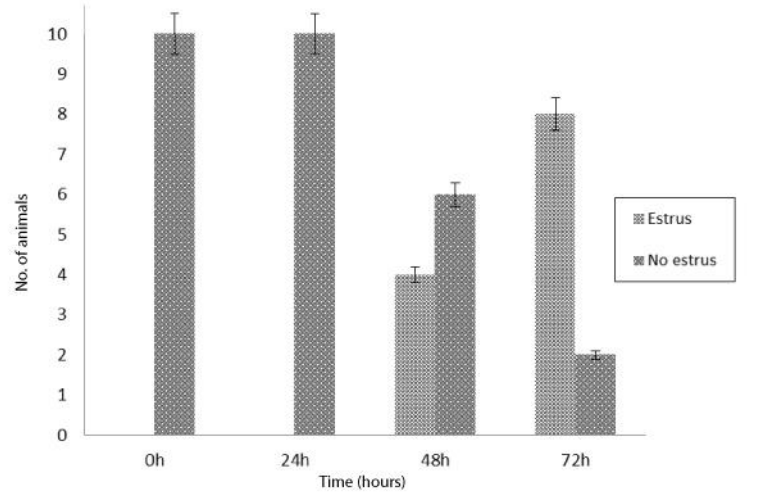
Figure 1: N umber of mice according to successful rate (estrus) and unsuccessful rate (no estrus) for 24 hours, 48 hours and 72 hours.